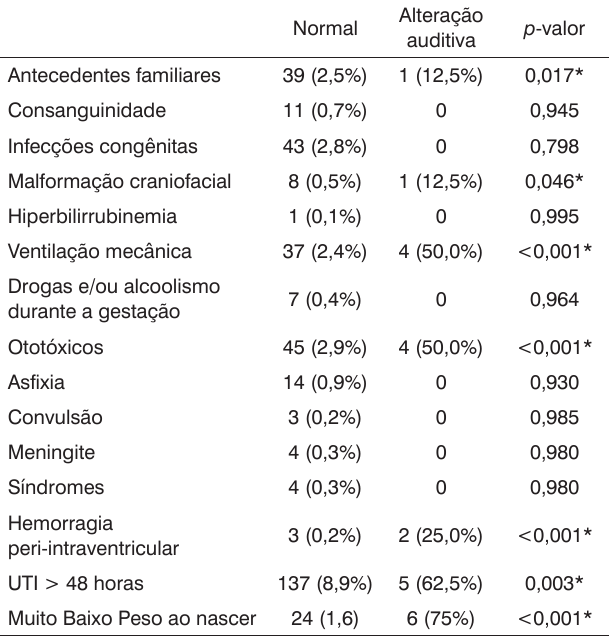
Tabela 5. Análise das crianças com alteração auditiva, segundo presença de indicadores de